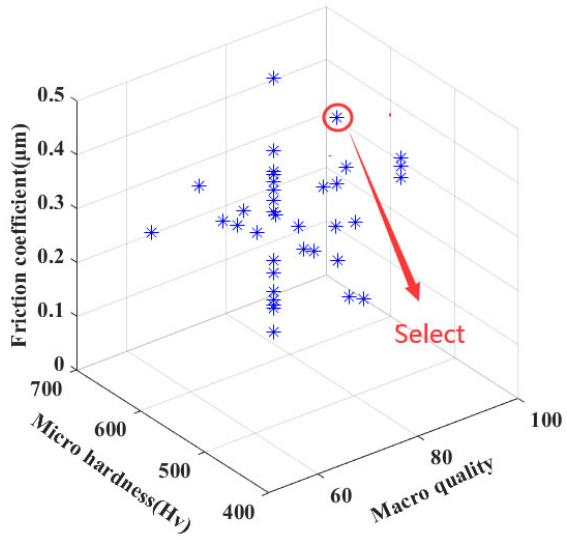
Figure 6. Optimized Pareto